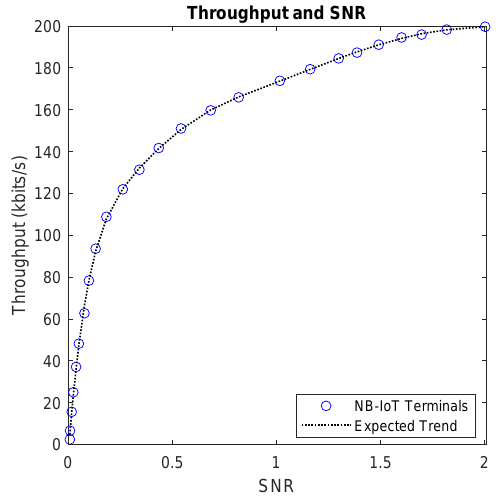
Figure 11. The Effect of SNR on Throughput.